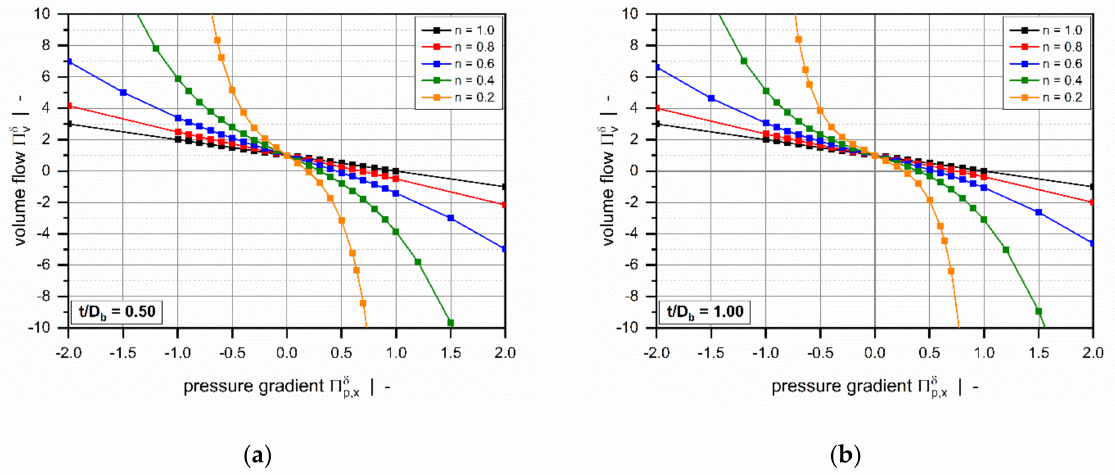
Figure 5. The volume flow rate Π δ as a function of pressure gradient Π δ p , x : Influence of power-law index for t / D b = 0.5 ( a ) V and t / D b = 1.0 ( b